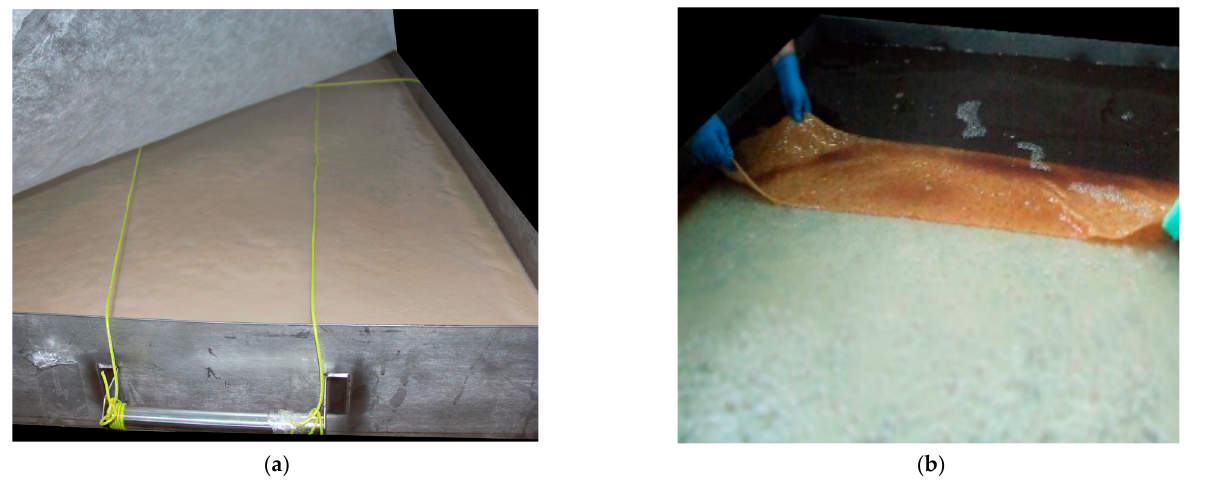
Figure 1. Biosynthesis of BNC sheets: ( a ) BNC sheet in the biosynthesis container 14 days post-cultivation and ( b ) removal of BNC sheet from the nutrient medium surface.